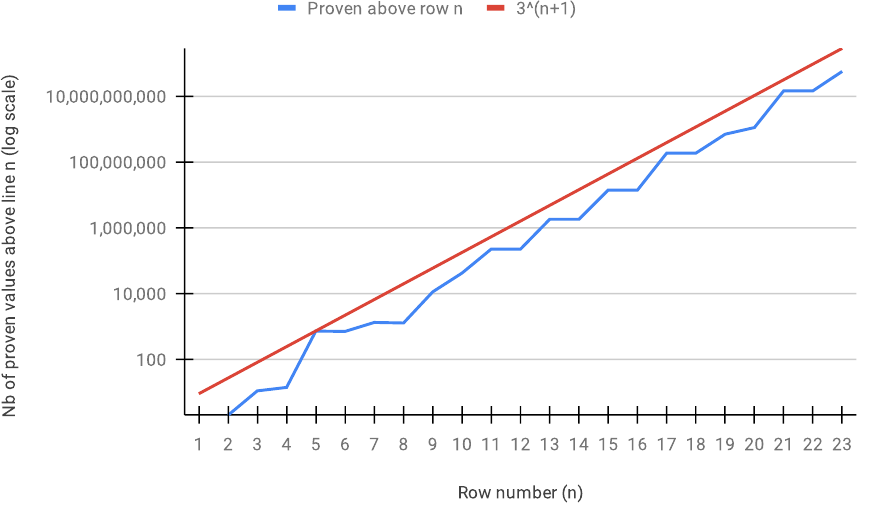
Figure 14. Amount of extra numbers proven by Golden Automaton II (log scale) after finishing any row n of the binary tree (x-axis), fit to the 3 n + 1 function